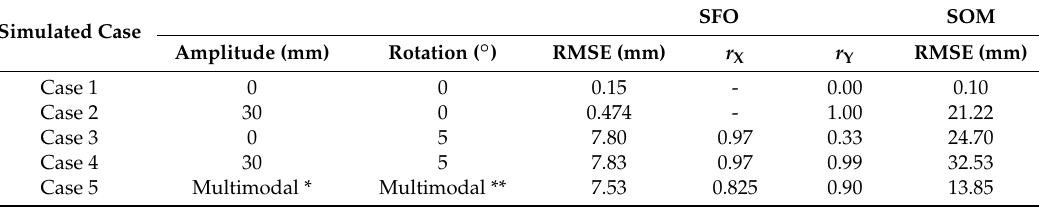
Table 1. Tabulation of the simulation results for SFO and SOM. r X denotes the Pearson correlation between the SFO X axis results and the theory X axis results. r Y denotes the same but for the Y axis. Only results with acceptable p -values ( p > 0.05) were displayed. The * symbol refers the reader to reference multimodal amplitude as defined by Equation (3), and the ** refers the reader to reference multimodal rotation as defined by Equation